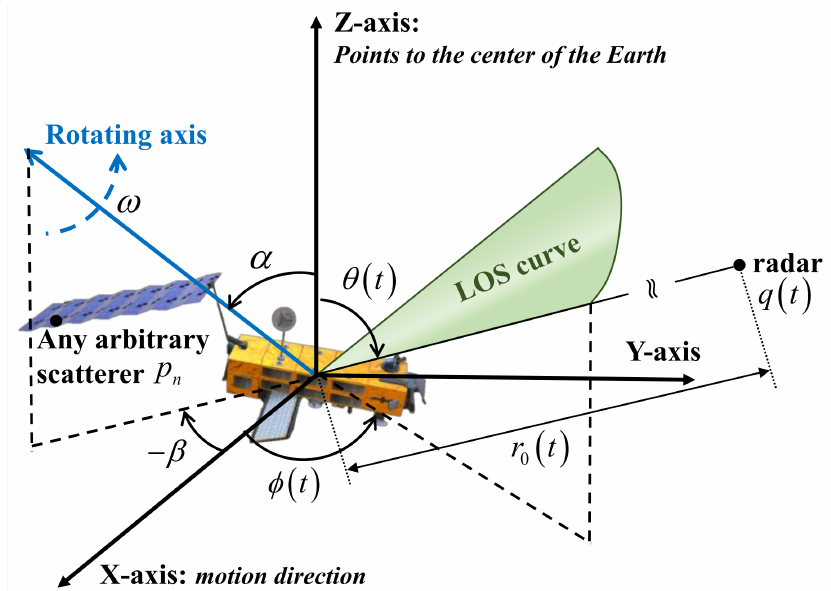
Figure 1. The ISAR observation and projection model for